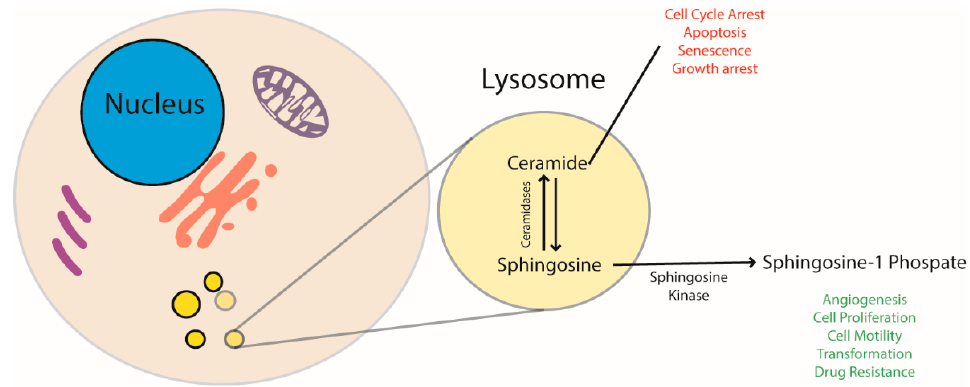
Figure 1. Ceramide and sphingosine-1-P regulate and stimulate opposite cellular pathways. The former has a pro-apoptotic e ff ect and blocks cell replication, the latter stimulates cells to proliferate. AC balances ceramides and sphingosine levels. Since sphingosine is then converted to sphingosine-1-P by sphingosine kinase, AC has a direct role in regulating cell life.